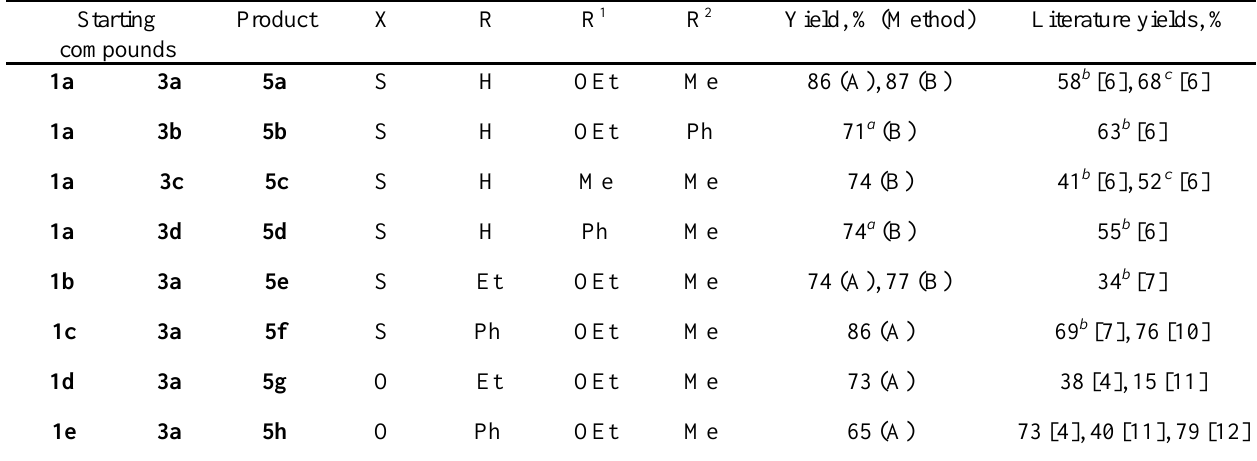
Table 2. Synthesis of 5-acyl-1,2,3,4-tetrahydropyrimidine-2-thiones/ones 5a-h